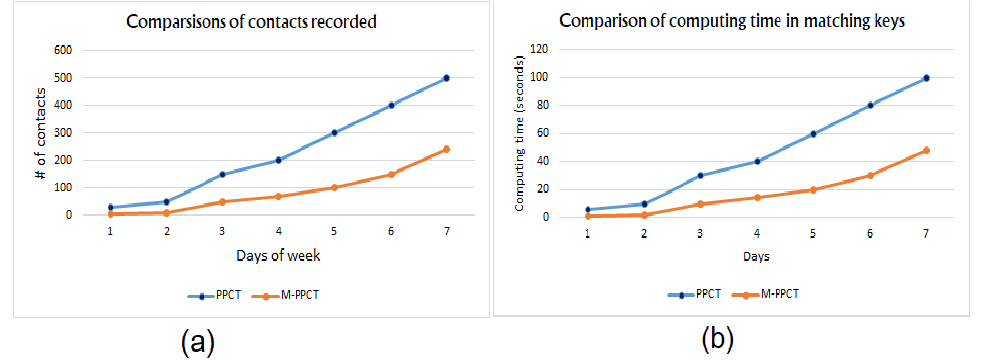
Figure 16. PPCT versus M-PPCT: comparisons of number of contacts ( a ) and computing speed ( b ).